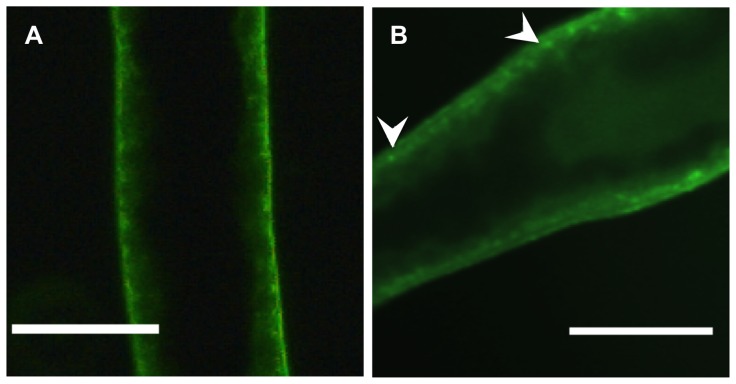
Distribution of the fluorescent edelfosine analog in S. mansoni adult female worms.A) Control of autofluorescence in a female cultured in RPMI-1640 only. B) Female incubated with the fluorescent edelfosine analog. Arrows show a slightly increased staining at the tegument. Scale bar, 0.2 mm.